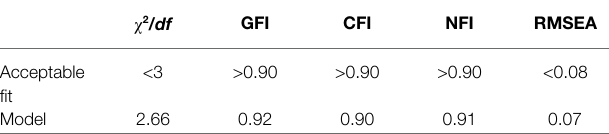
TABLE 8 | Goodness of fit